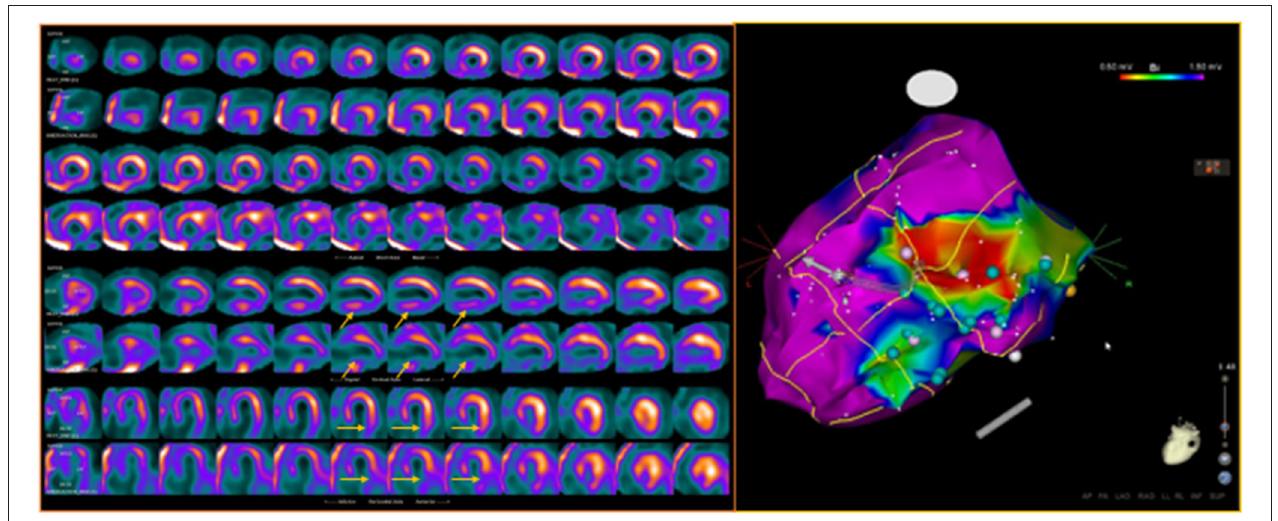
FIGURE 5 | Dual-tracer scintigraphy in a patient with previous inferior myocardial infarction and recent episodes of ventricular tachycardia. Left: The 99m Tc-tetrofosmin rest single-photon emission CT (SPECT) images show the presence of an inferior myocardial infarction (top rows; SRS 12). The 123I -MIBG (bottom rows) innervation images showed a large area of absence of tracer uptake (no-innervation) from the basal to mid-ventricular lateral walls and in the inferior wall (SS-MIBG 19). A large area of innervation/perfusion mismatch was detected in the lateral left ventricular (LV) wall. Right: The electrophysiology (EP) study identified the arrhythmic focus in the inferior and infero-lateral LV walls, corresponding to the area of denervated myocardium. The ablation procedure was performed at the level of the inferior scar as well as of the viable infero-lateral wall. Pink dot, fragmented signals. White dot, late potential. Blue dot, double